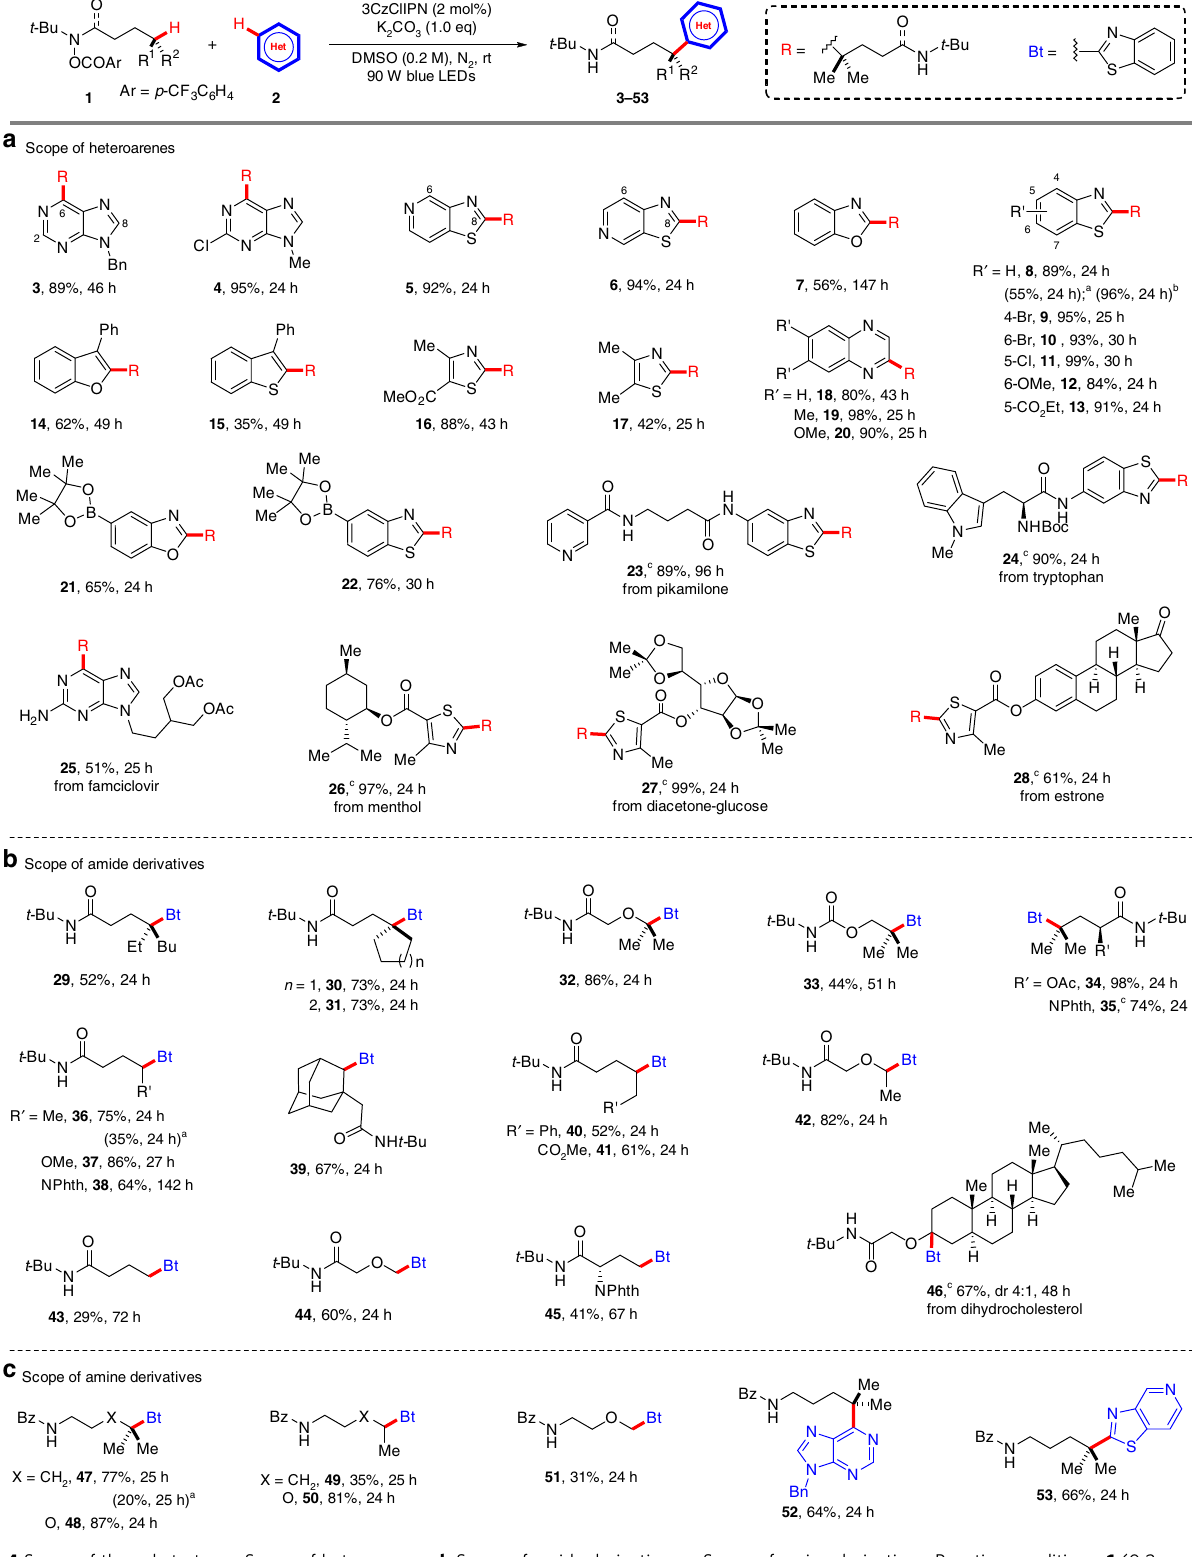
Fig. 4 Scope of the substrates. a Scope of heteroarenes. b Scope of amide derivatives. c Scope of amine derivatives. Reaction conditions: 1 (0.2 mmol, 1.0 equiv), 2 (0.5 mmol), K 2 CO 3 (0.2 mmol), and 3CzClIPN (2 mol%) in DMSO (1.0 mL), rt, 90 W blue LEDs. Yields are based on the isolated products. a Without 3CzClIPN. b 5 mmol scale of 1a . c 0.1 mmol scale of 1a , 1 h , and 1 s ,